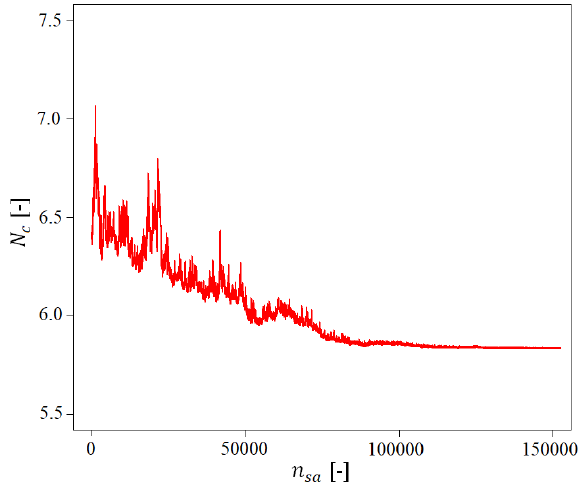
Figure 2: Value of bearing capacity during simulation within optimization